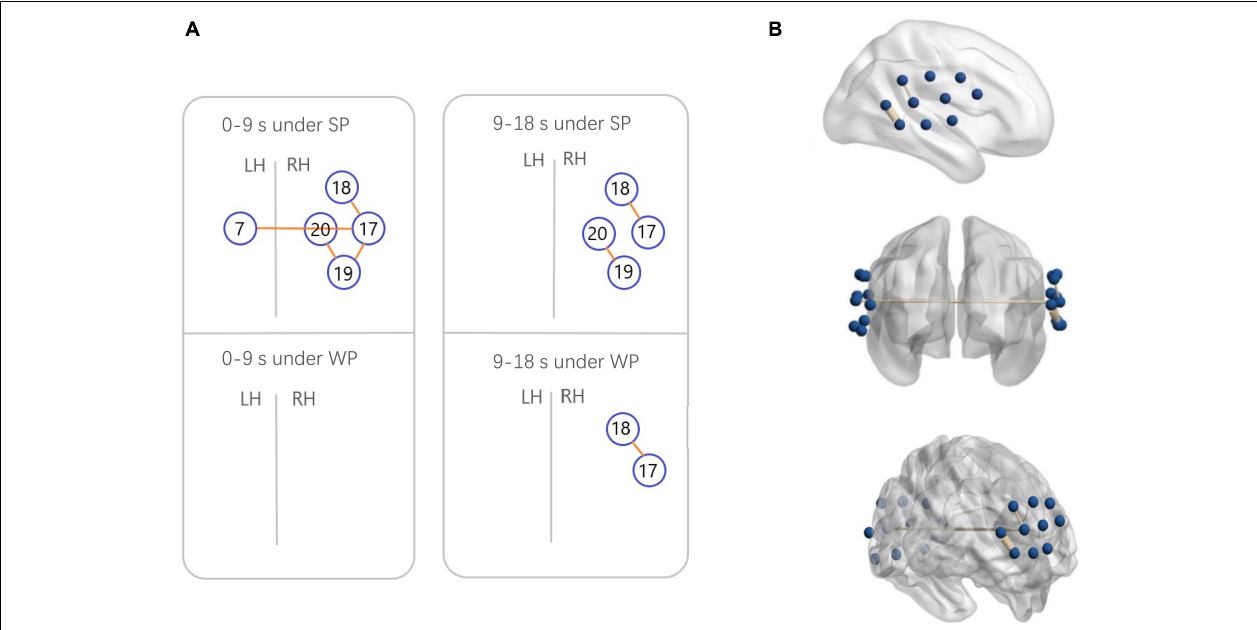
FIGURE 7 | Functional connectivity (FC) maps among the activated cortical regions in the normal hearing (NH) group. (A) Blue circles indicate channels, and the orange lines show correlations greater than 0.6 (average across all participants). A significant correlation was found in Ch7-17 [ r = 0.6231], Ch17-18 [ r = 0.6222], Ch17-19 [ r = 0.6194], and Ch19-20 [ r = 0.6304] under strong-prosodic (SP) condition in time-window of 0–9 s. Under SP condition in time-windows of 9–18 s, significant correlation was found in Ch17-18 [ r = 0.6561], Ch19-20 [ r = 0.6088]. Correlation under weak-prosodic (WP) condition in time windows of 9–18 s was found in Ch17-18 [ r = 0.6215]. (B) FC in the NH group under SP condition on the standard brain in time-windows of 0–9 s in different views. The blue dots indicate 20 channels, and the yellow lines show correlations greater than 0.6 (average across all